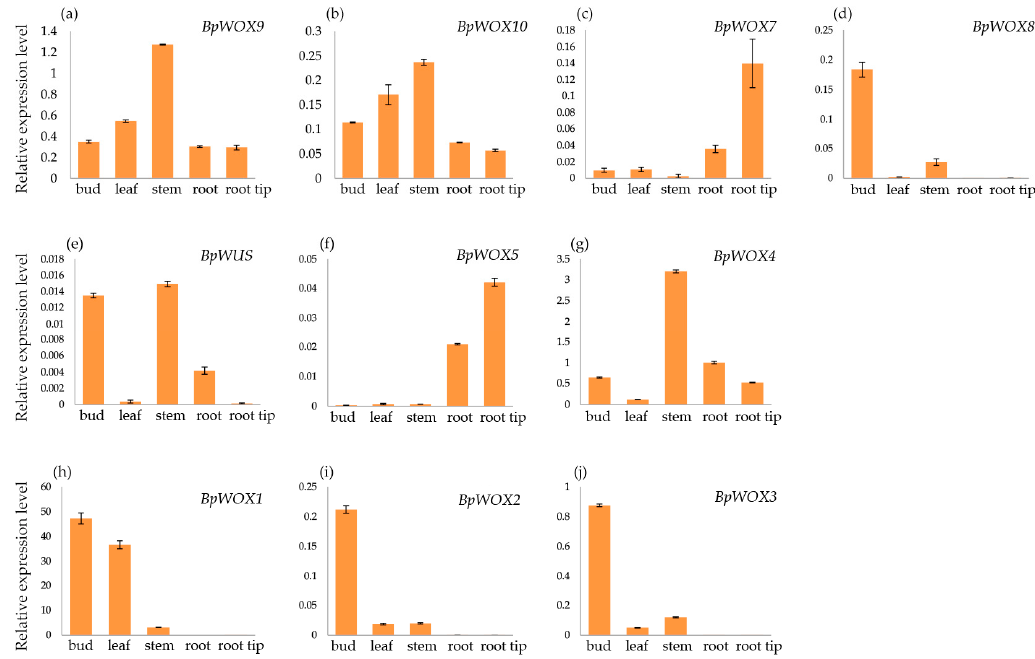
Figure 6. The expression patterns of BpWOX genes in different tissues. The expression level of BpWOX9 ( a ); BpWOX10 ( b ); BpWOX7 ( c ); BpWOX8 ( d ); BpWUS ( e ); BpWOX5 ( f ); BpWOX4 ( g ); BpWOX1 ( h ); BpWOX2 ( i ); and BpWOX3 ( j ) in the apical bud, leaf, stem, root, and root tip. Transcript levels were determined by qRT-PCR. Expression of BpGAPDH was used as an internal control. Error bars indicate standard deviation of three independent biological replications.